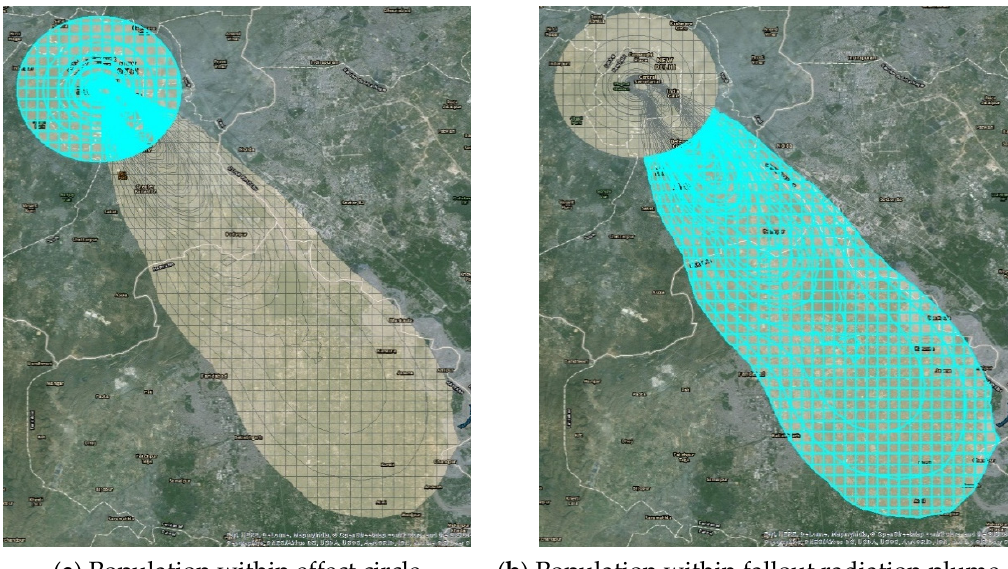
Figure 3. Calculation of human casualty data.